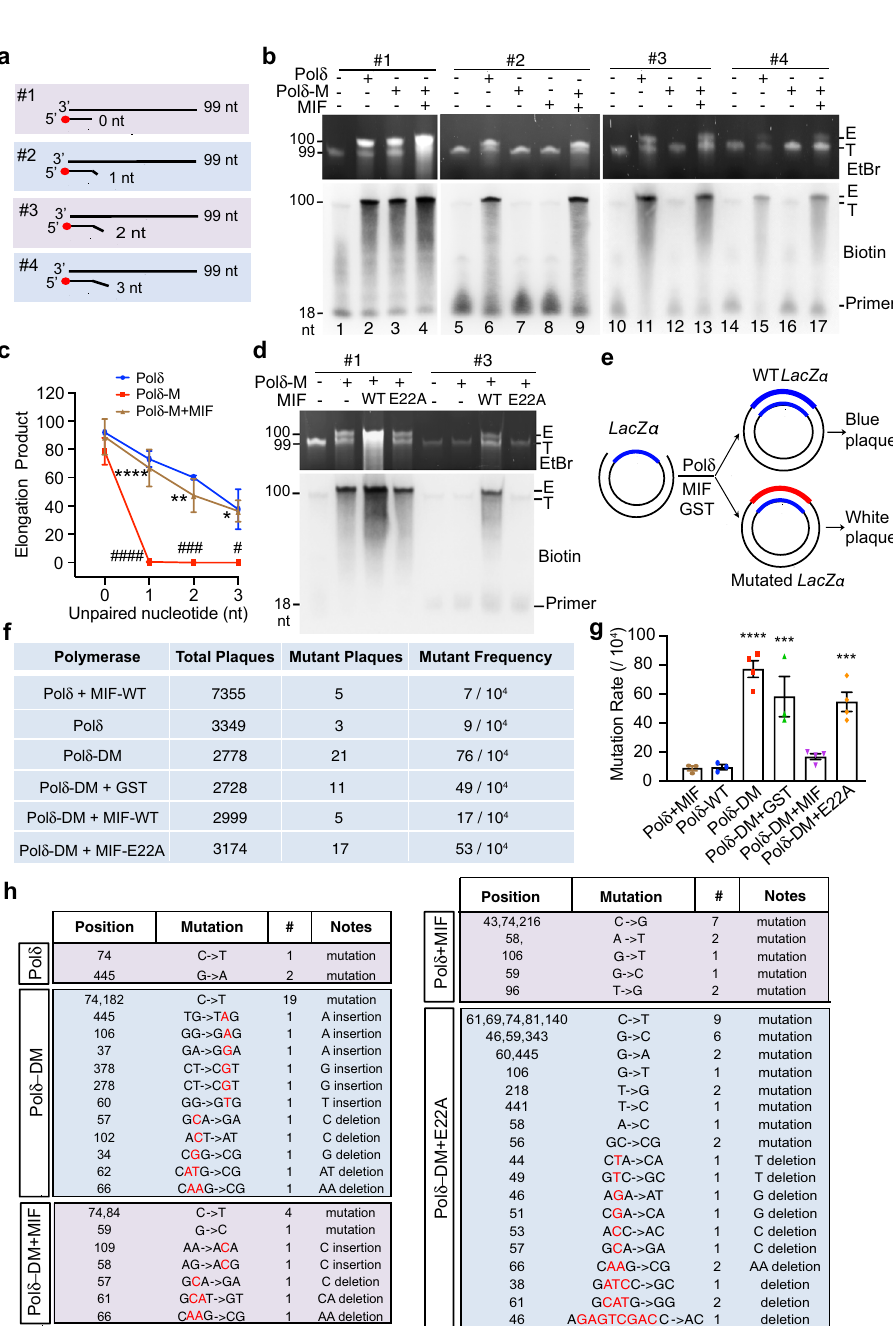
Fig. 2 MIF coordinates with the nuclease-de fi cient Pol δ D402A mutant to facilitate DNA elongation. a Scheme of four types of 5 ’ biotin-labeled short DNA primers complementary to the template DNA without or with 1 – 3 nt mismatched nucleotides at the 3 ’ end for in vitro DNA elongation assay. b In vitro DNA elongation assay mediated by Pol δ or 3 ’ nuclease-de fi cient Pol δ D402A mutant (Pol δ -M) (5 ng/ μ l) in the presence or absence of MIF (2 μ M)